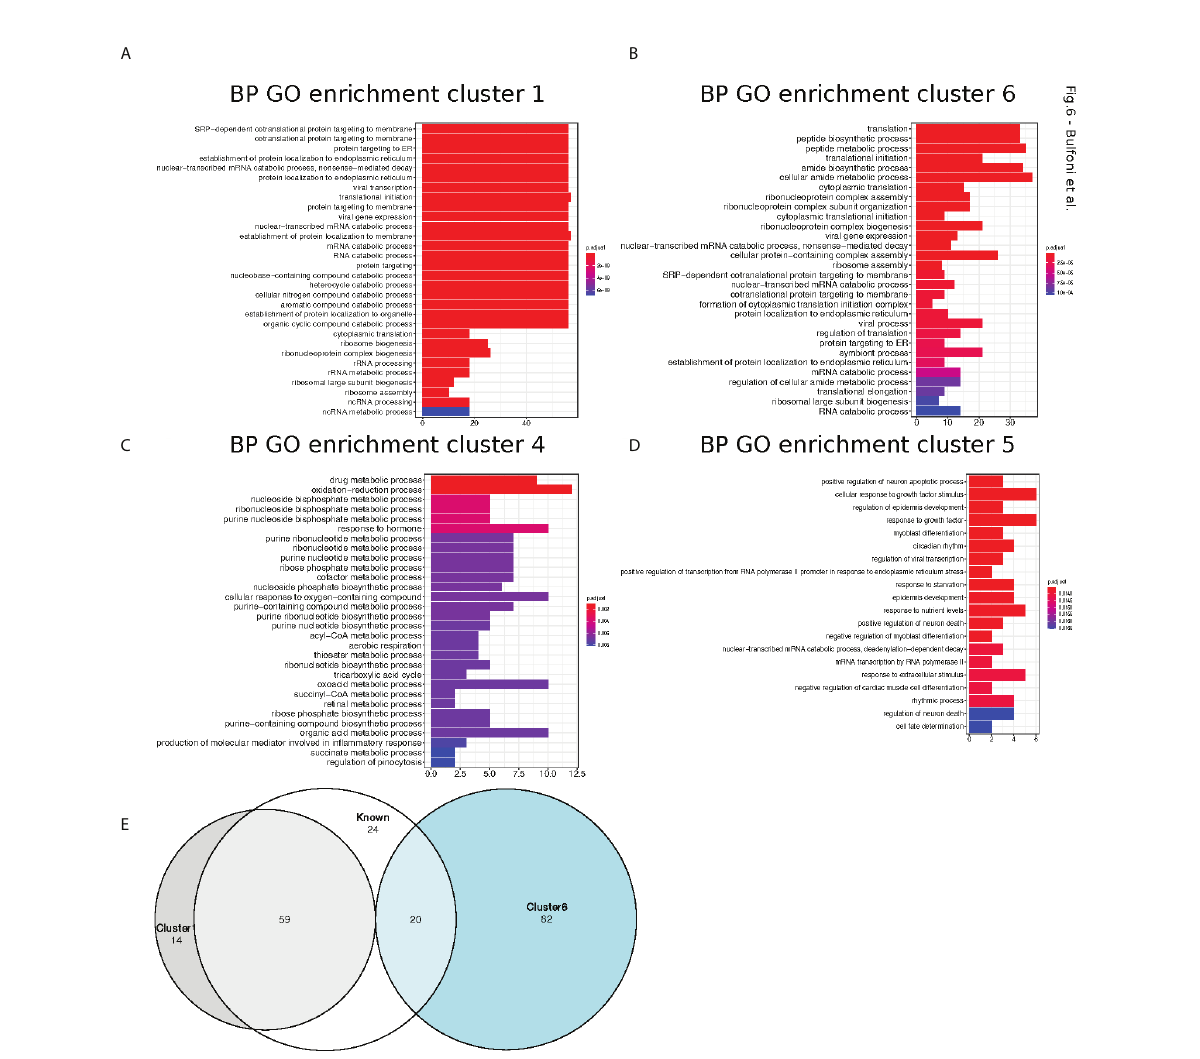
FIGURE 6 Cluster Gene Ontology enrichment. (A – D). barplot of gene ontology terms enriched for biological processes for clusters 1, 4, 5 and 6 using the R package clusterPro fi ler. (E). Venn diagram of genes belong to cluster 1 (grey circle) and 6 (blue circle) with previously reported TOP-RNAs (white